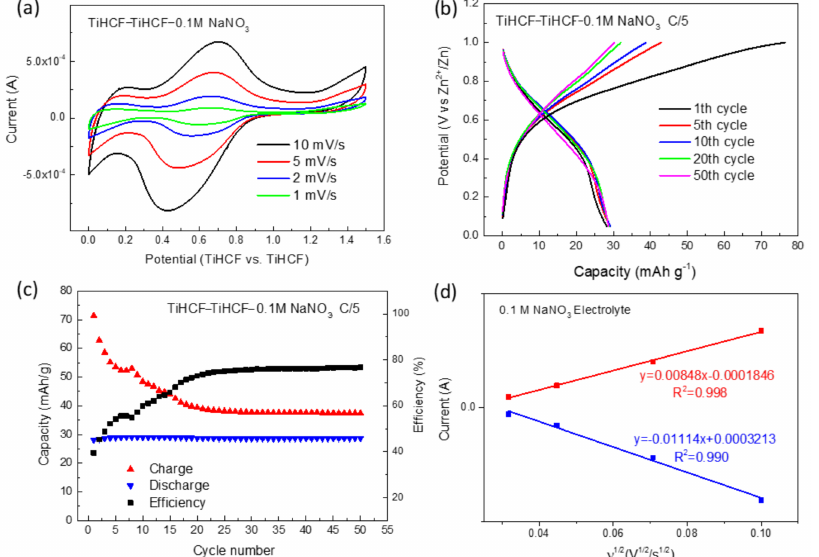
Figure 3. Schematic illustration of the aqueous symmetric sodium-ion battery with TiHCF as the anode and the cathode.